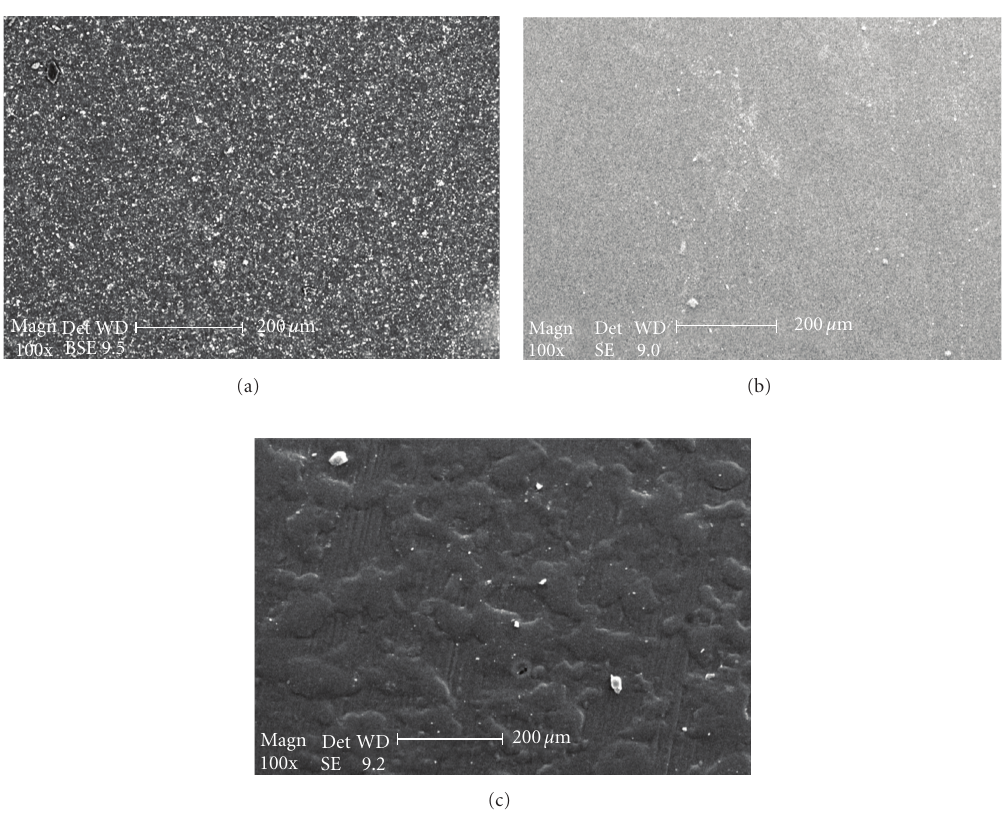
Figure 1: (a) SEM micrograph of sample code, C 5 . (b) SEM micrograph of sample code, nC 5 . (c) SEM micrograph of sample code, nC 8